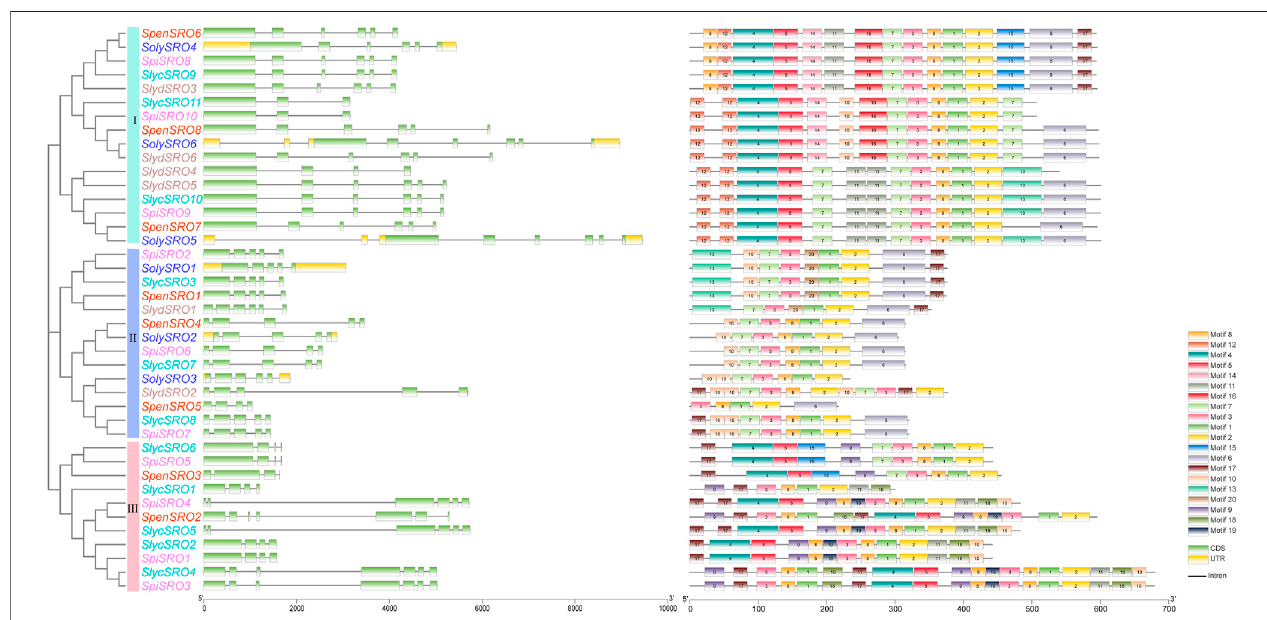
FIGURE 2 | Phylogenetic relationships, Structure and conserved motifs of SRO genes in tomato species. The different coloured SRO genes were derived from different tomato species. Green boxes indicate exons, yellow boxes indicate UTR and black lines indicate introns. The numbers 1 – 20 and the different colored boxes indicate